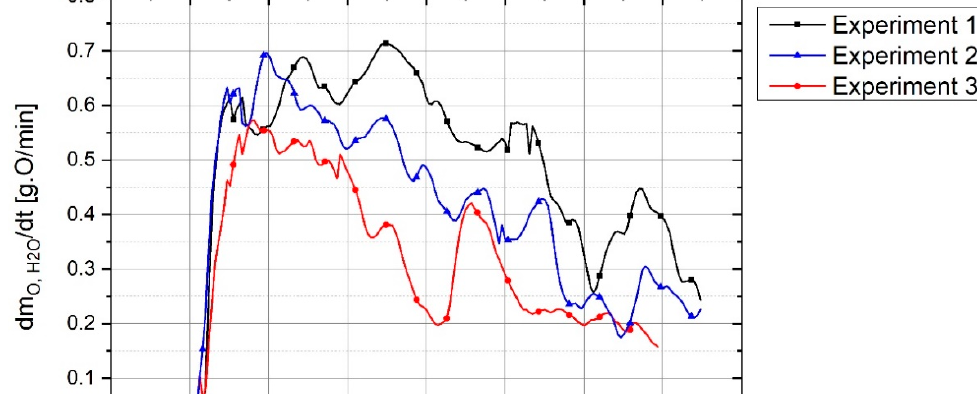
Figure 14. 𝜂 (cid:2892)